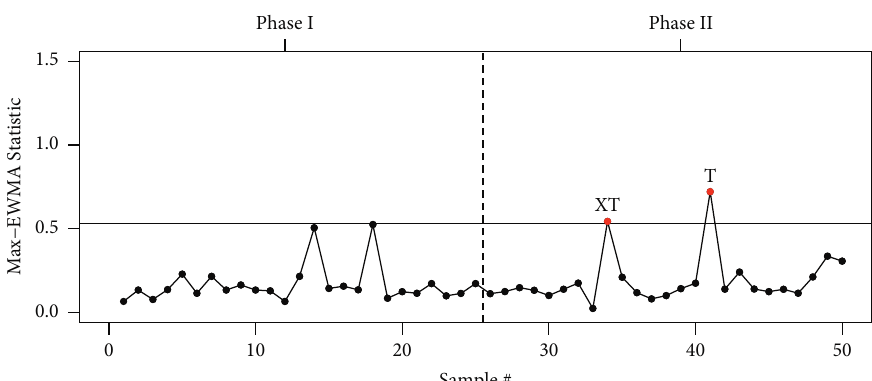
Figure 2: Max-EWMA chart for monitoring the fire outbreaks considering the pure shift in the shape 1 parameter of beta distribution.